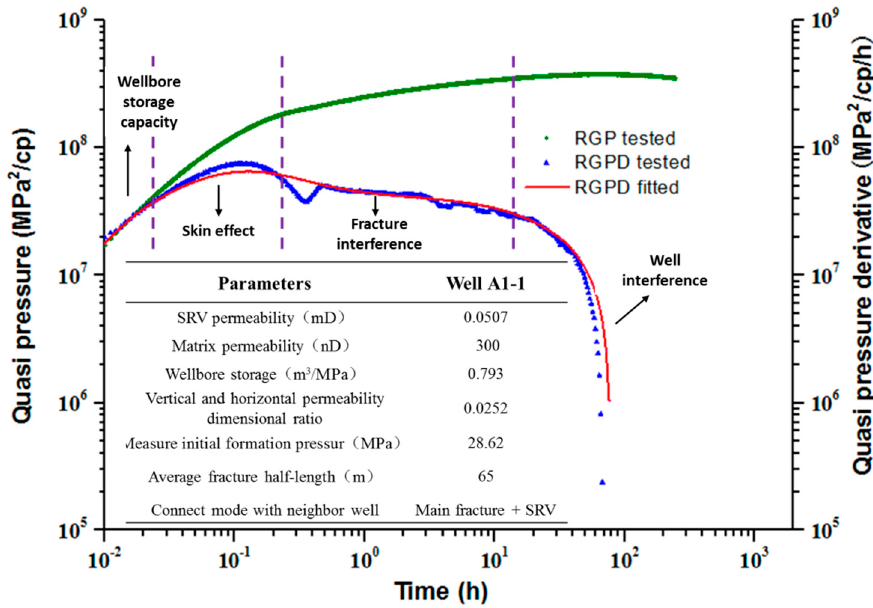
Figure 3. Double logarithmic curve fitting results for pressure recovery in well A1-1.